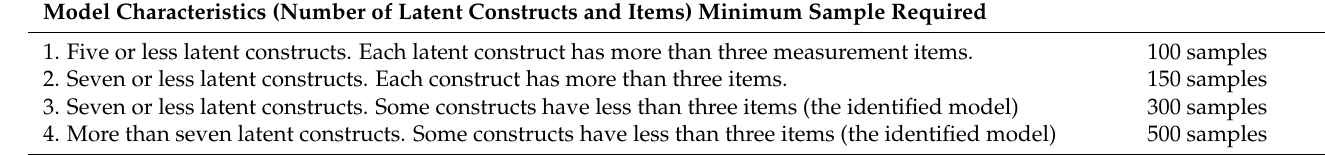
Table A1. Minimum sample size required for SEM